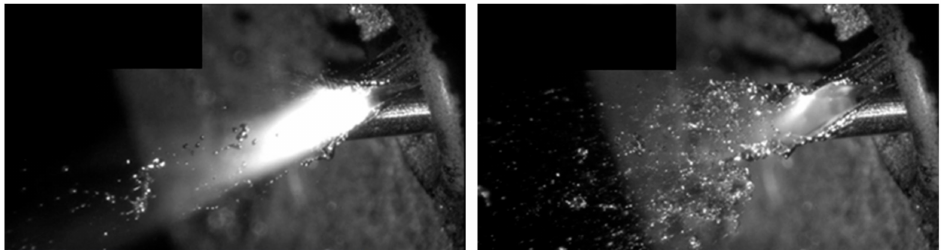
Figure 8. Particle formation during wire arc spraying with pulsed alternating current at time ( left ): t = 194.0 ms, ( right ): t = 194.35